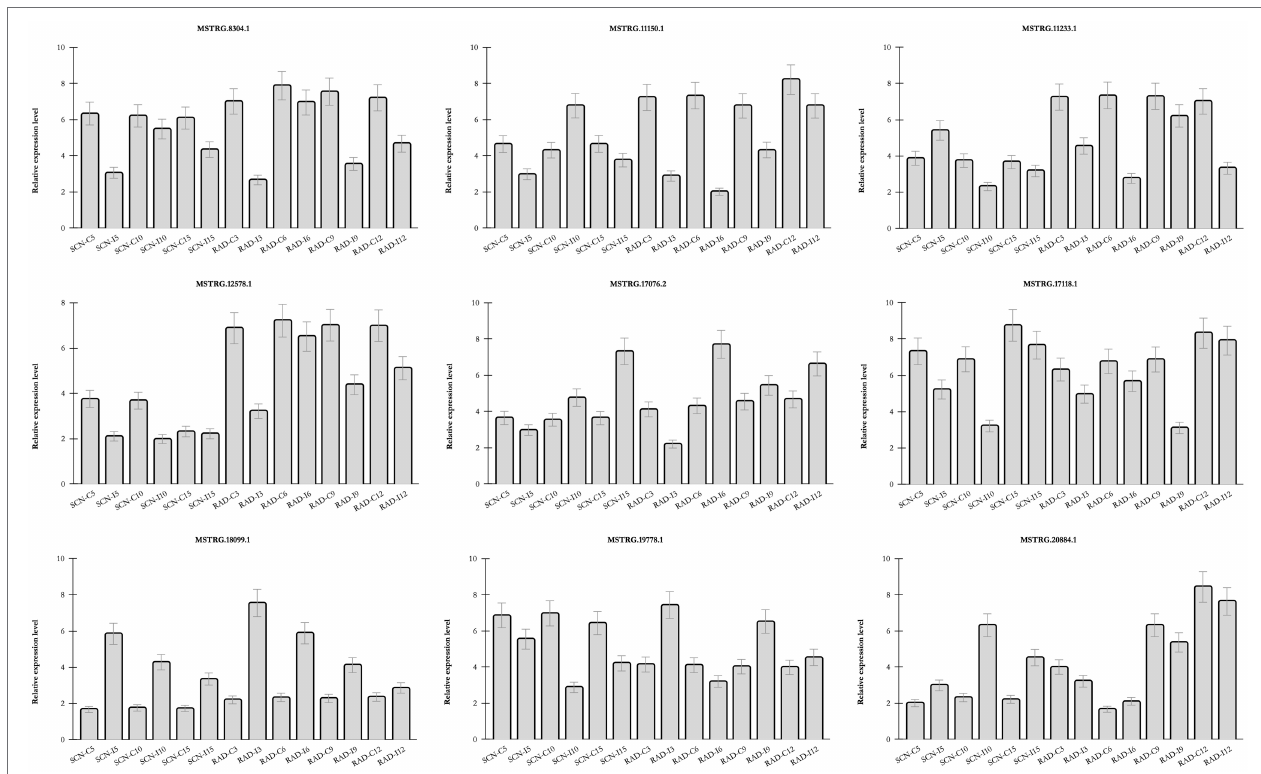
FIGURE 7 | Relative expression of lncRNAs by qPCR Transcript levels of nine selected lncRNAs in roots of soybean plants under similar conditions to SCN data set and RAD and in three biological replicates. Bars show mean values of these replicates (+/ − standard